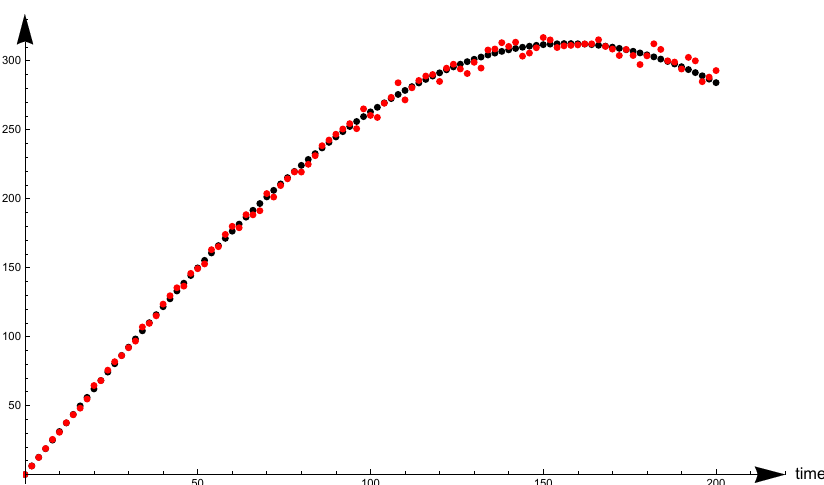
Figure 3. Disturbed (red dots) and exact (black dots) values of the function u at measuring point K 4 (disturbed with the error